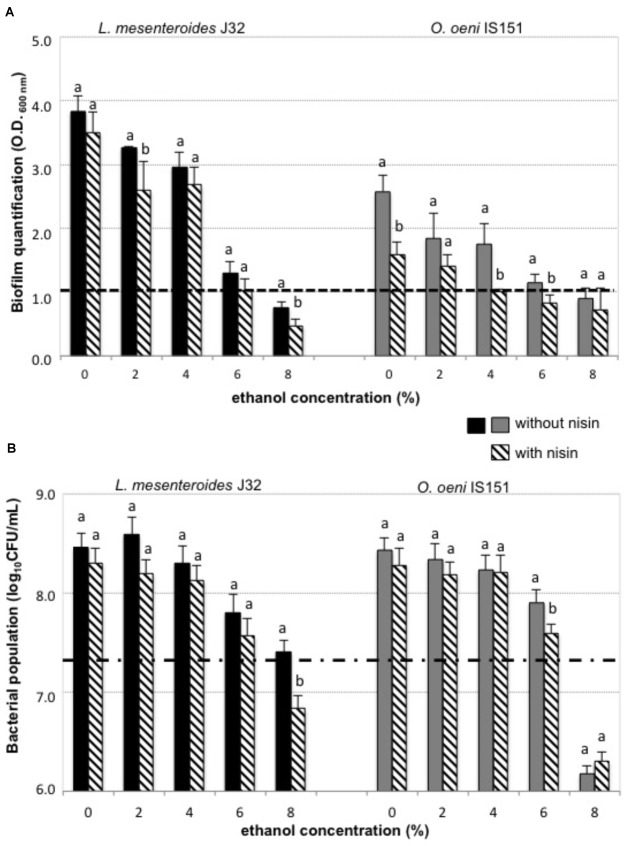
Biofilm formation and bacterial growth in presence of nisin and ethanol in the culture broth of planktonic cells, (A) biofilm was quantified after 48 h incubation without nisin (solid color bars) or with 6 μg/mL nisin (diagonal striped bars) in the culture broth and with (0–8%) ethanol: dashed line (1 a.u.): above which it is considered positive biofilm formation, (B) bacterial growth was quantified after 48 h incubation without nisin (solid color bars) or with 6 μg/mL nisin (diagonal striped bars) in the culture broth and with (0–8%) ethanol; dashed line: initial bacterial population above which it is positive the bacterial growth of L. mesenteroides J32 (black bars) and O. oeni IS151 (gray bars).